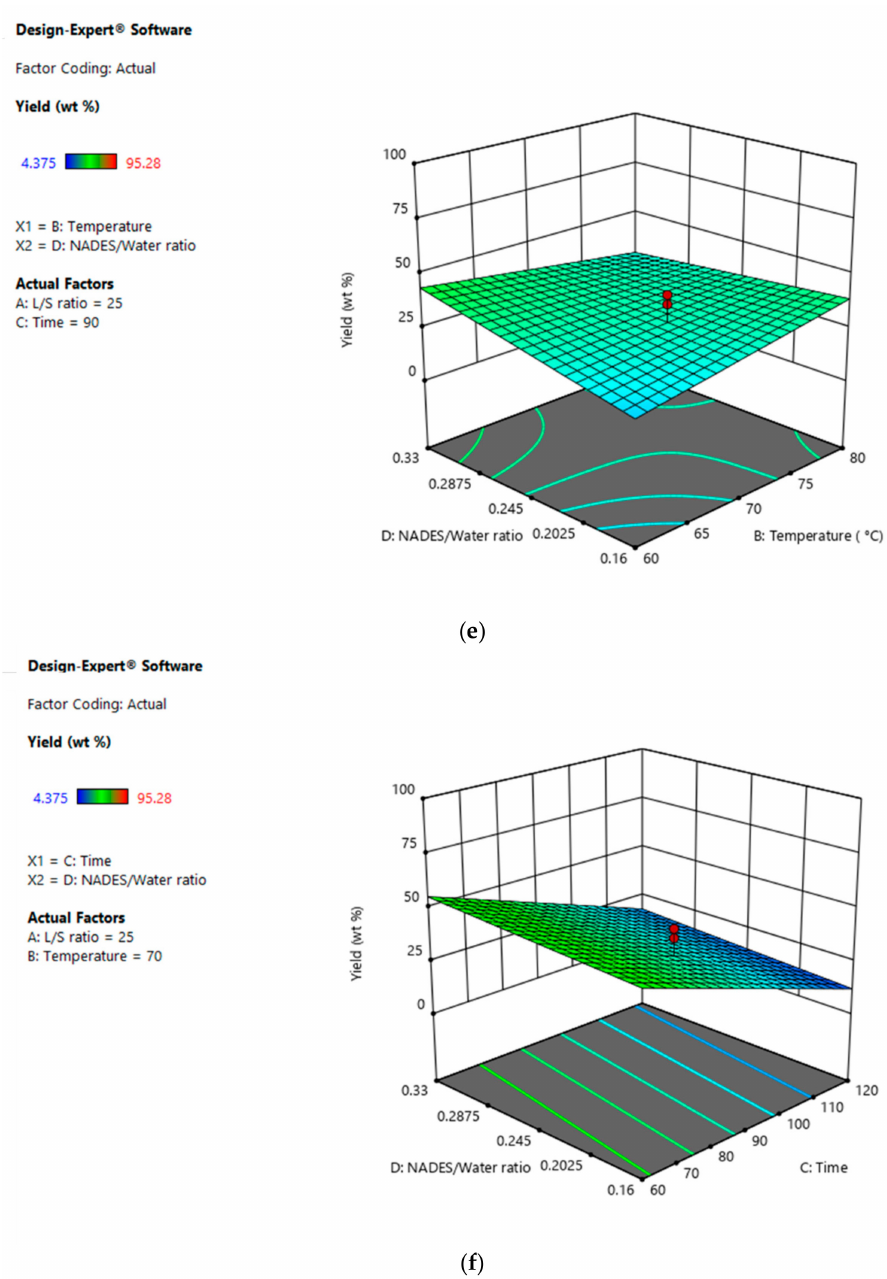
Figure 1. Three-dimensional (3D) surface plot of pectin yield with four factors (liquid / solid loading, temperature, time, and natural deep eutectic solvent (NADES) / water ratio in ChCl–Mal. ( a ) Liquid / solid ratio vs. temperature; ( b ) liquid / solid ratio vs. time; ( c ) liquid / solid ratio vs. NADES / water ratio; ( d ) temperature vs. time; ( e ) temperature vs. NADES / water ratio; ( f ) time vs. NADES / water ratio. The degree of esterification DE% ranged from 35–62% with the maximum obtained at runs 6 and 10. It was also observed that the yield was not associated with the DE%, as seen from runs 2 and 9, where high DE% (50–60%) was achieved regardless of the low pectin yield (7–14%). Validation of the model was conducted based on the solution obtained from the analysis. ◦ For instance, one provided solution was liquid / solid ratio 35.23%, temperature 78.2 C, time 64 min, NADES / water ratio 1:3: 100, desirability = 1, yield = 95.3%, DE = 70.92%. A number of optimization solutions (100) were obtained upon analysis, three of which are presented in Table 6.